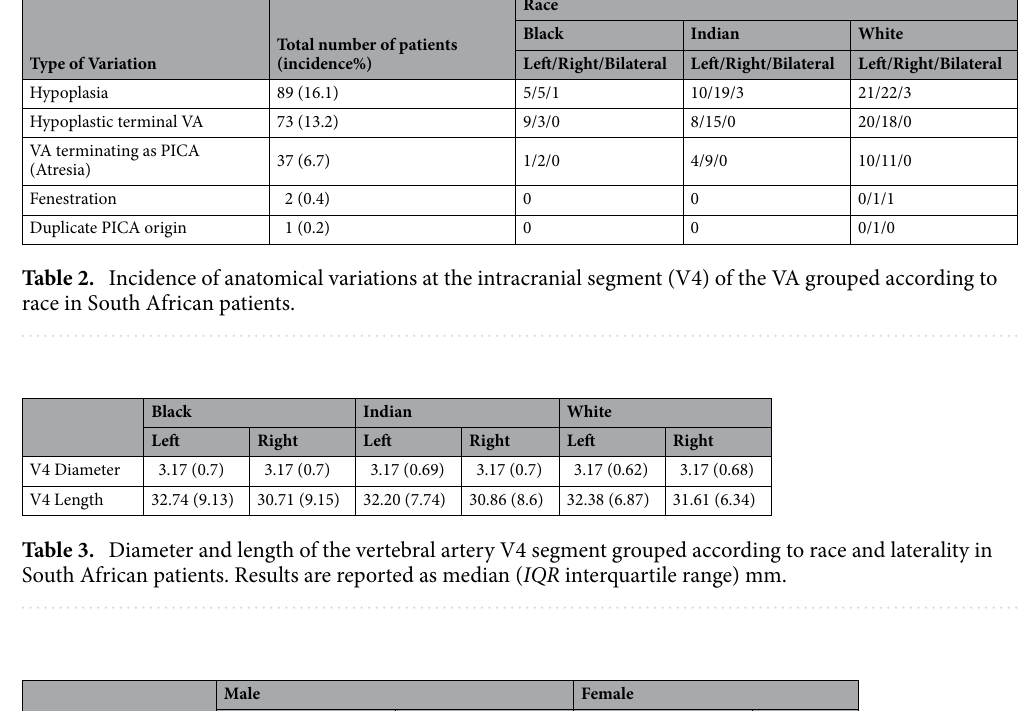
Male Female Left Right Left Right V4 Table 4. Diameter and length of the vertebral artery V4 segment grouped according to gender and laterality in South African patients. Results are reported as median ( IQR interquartile range) mm.